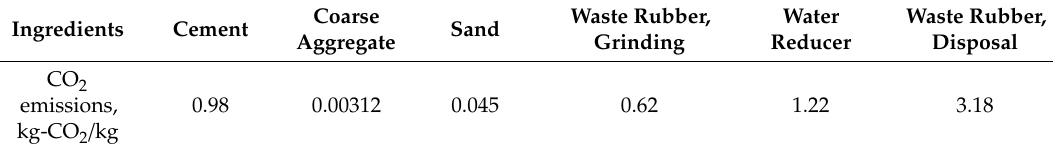
Figure 7. Life cycle assessment (LCA) model of concrete. Table 3. Carbon intensities of ingredients of various concretes.